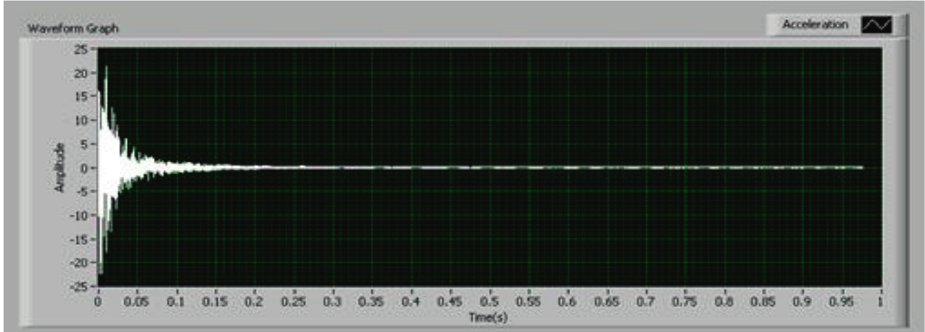
Figure 4: Time (sec) domain excitation response of A3 steel under natural frequency.